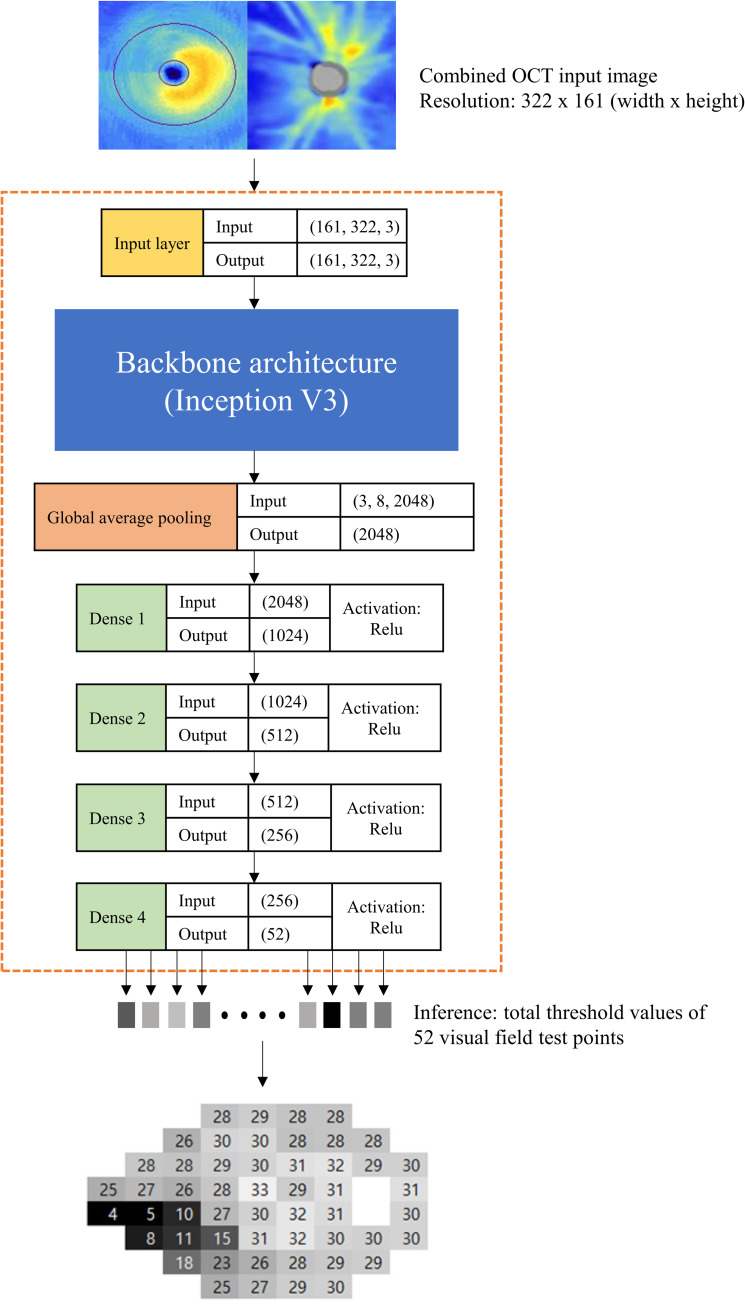
Deep learning architecture.The shape of the tensor (input/output) is described on the right side of each layer box. The global average pooling layer and four fully connected network (dense) layers were connected after the Inception V3 backbone CNN (convolutional neural network) architecture. The four dense layers used ReLu (rectified linear unit) as the activation function.